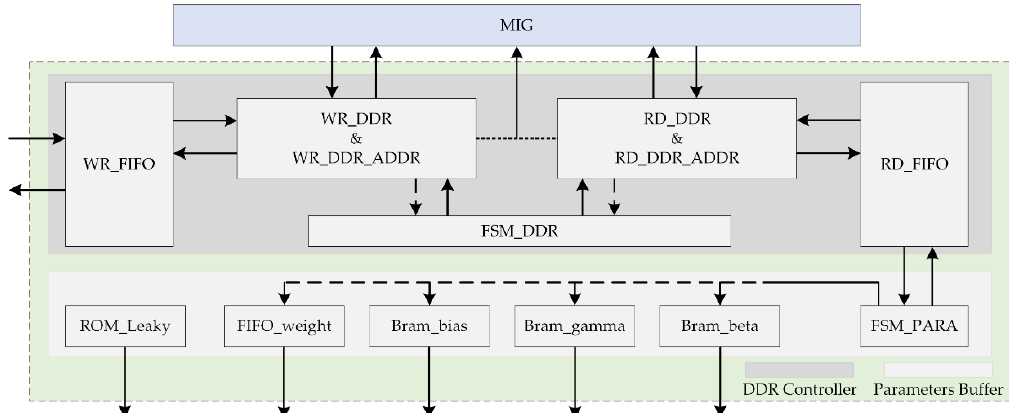
Figure 10. The diagram of the input data reordering module.